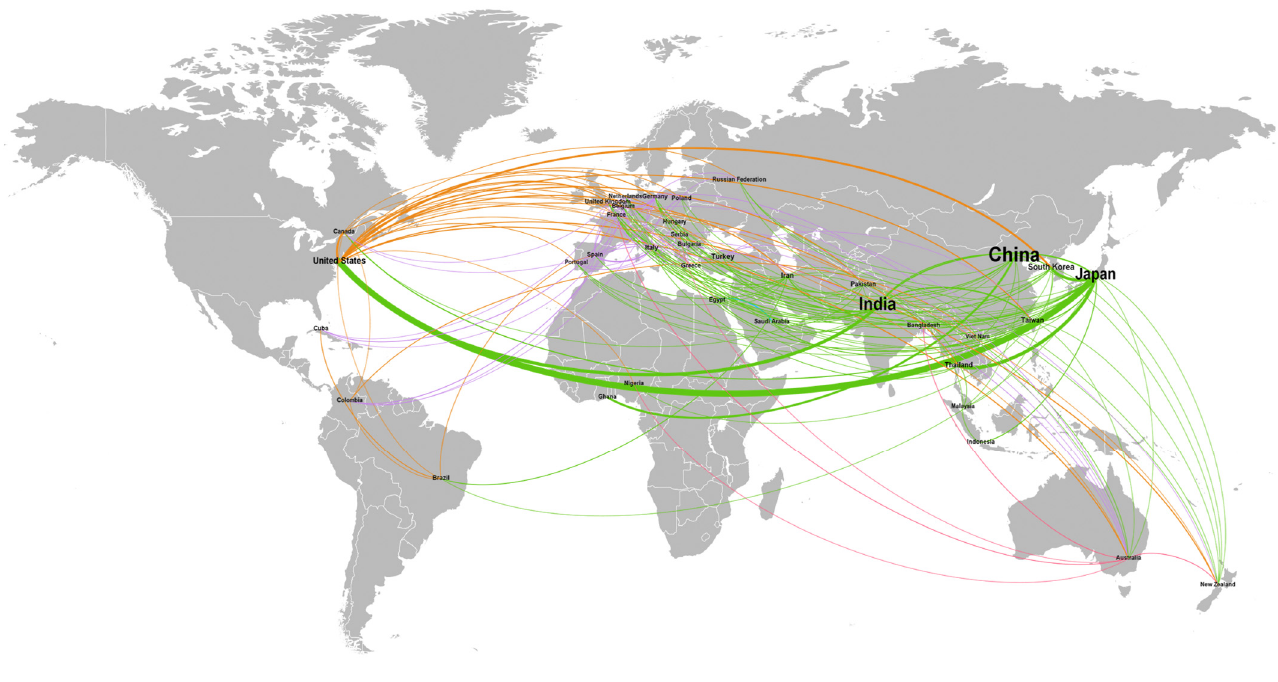
Figure 4. Geographic extent of collaborations for research in sericulture-related topics.